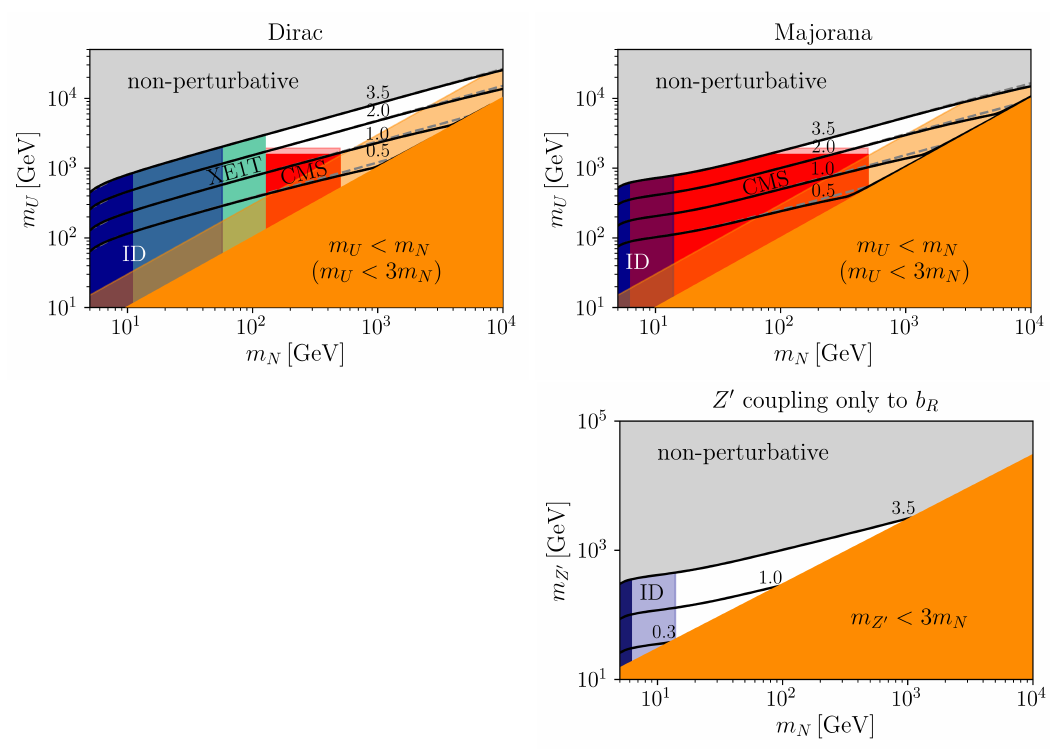
| in the m Figure 7: Upper: contours of | x - m -plane producing the correct relic b N U abundance. Dashed lines correspond to the EFT limit of the given coupling. Con- straints from indirect and direct detection are very weak. CMS limits are shown in < 3 m red, perturbativity of the coupling and validity of the EFT description ( m in S N < m orange, m in light orange) are also indicated. Lower: same plot for Z (cid:48) models S N coupling only to the B − L charge of right-handed top quarks. Contours of g pro- X ducing the correct relic abundance are shown in black, the Z - Z (cid:48) mixing parameter ε is